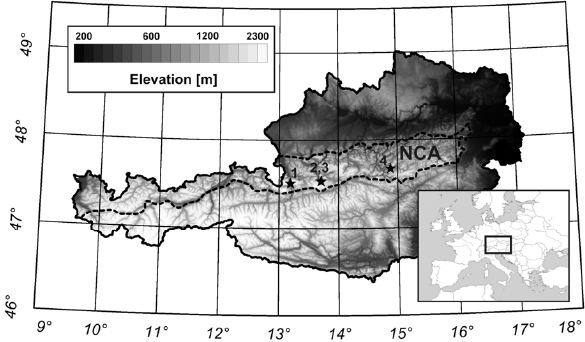
Figure 1: Location of the investigated caves: 1 - Eisriesenwelt; 2, 3 - Dachstein- Fig. 1. Location of the investigated caves: 1 – Eisriesenwelt; 2, 3 – Mammuthöhle, Dachstein-Rieseneishöhle; 4 - Beilstein-Eishöhle. The broken line displayed Dachstein-Mammuth¨ohle, Dachstein-Rieseneish¨ohle; 4 – Beilstein- over the digital elevation model encompasses the Northern Calcareous Alps (NCA). Eish¨ohle. The broken line displayed over the digital elevation model encompasses the Northern Calcareous Alps